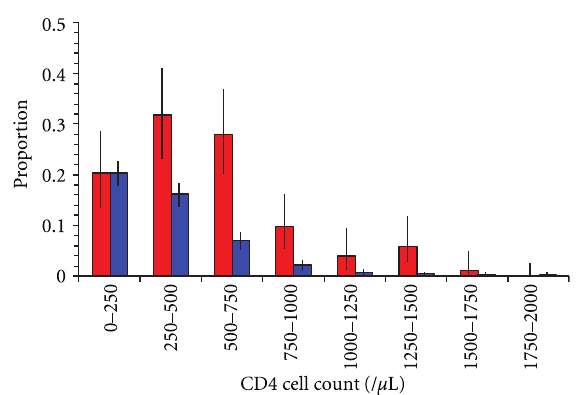
Figure 2: Comparison of the CD4 cell count distribution in Nyanza Province (red; KAIS survey) and the Kisii Hospital cohort (blue). The data for the hospital cohort are scaled to match the KAIS data for the lowest CD4 cell count range and the di ff erences in the heights of the bars for the higher ranges show the proportion that are missed in the hospital